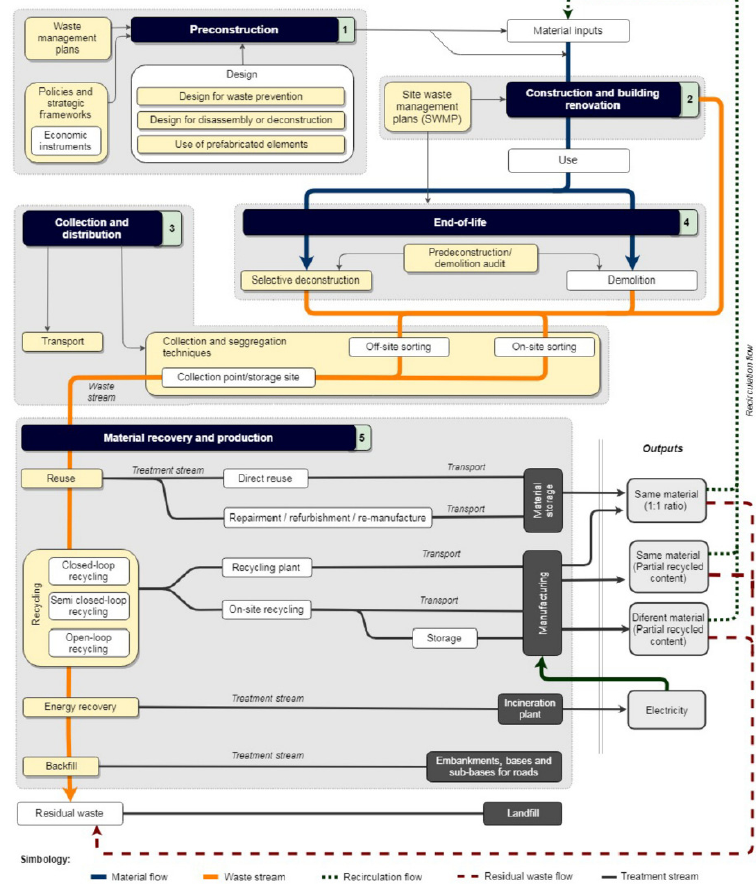
Figure 8. Framework for circular economy adoption in construction [107] .